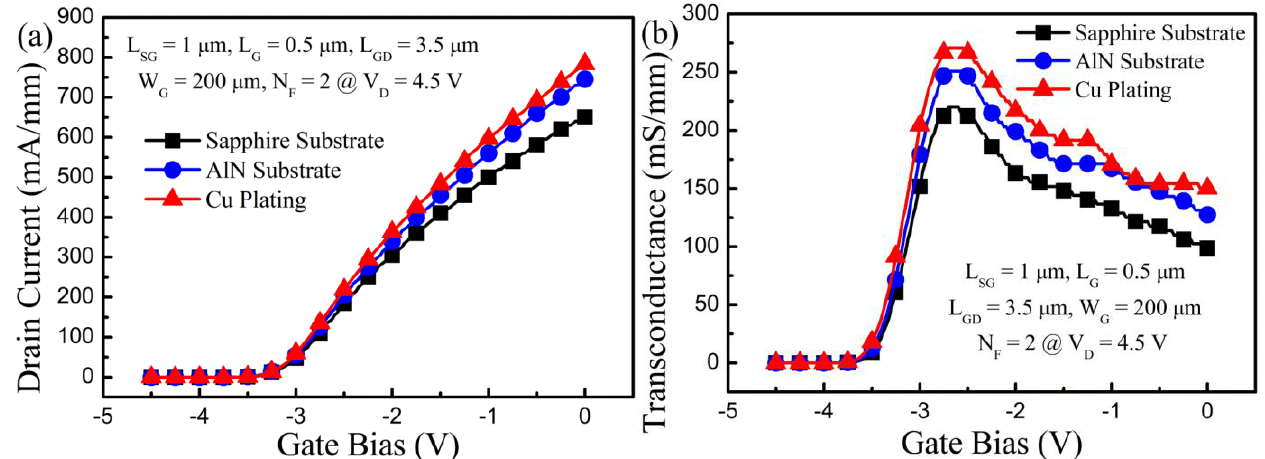
Figure 3. Transfer characteristics of GaN-based HEMTs operated on sapphire substrate, AlN substrate, and Cu film. ( a ) Drain current and ( b ) transconductance as a function of gate bias.